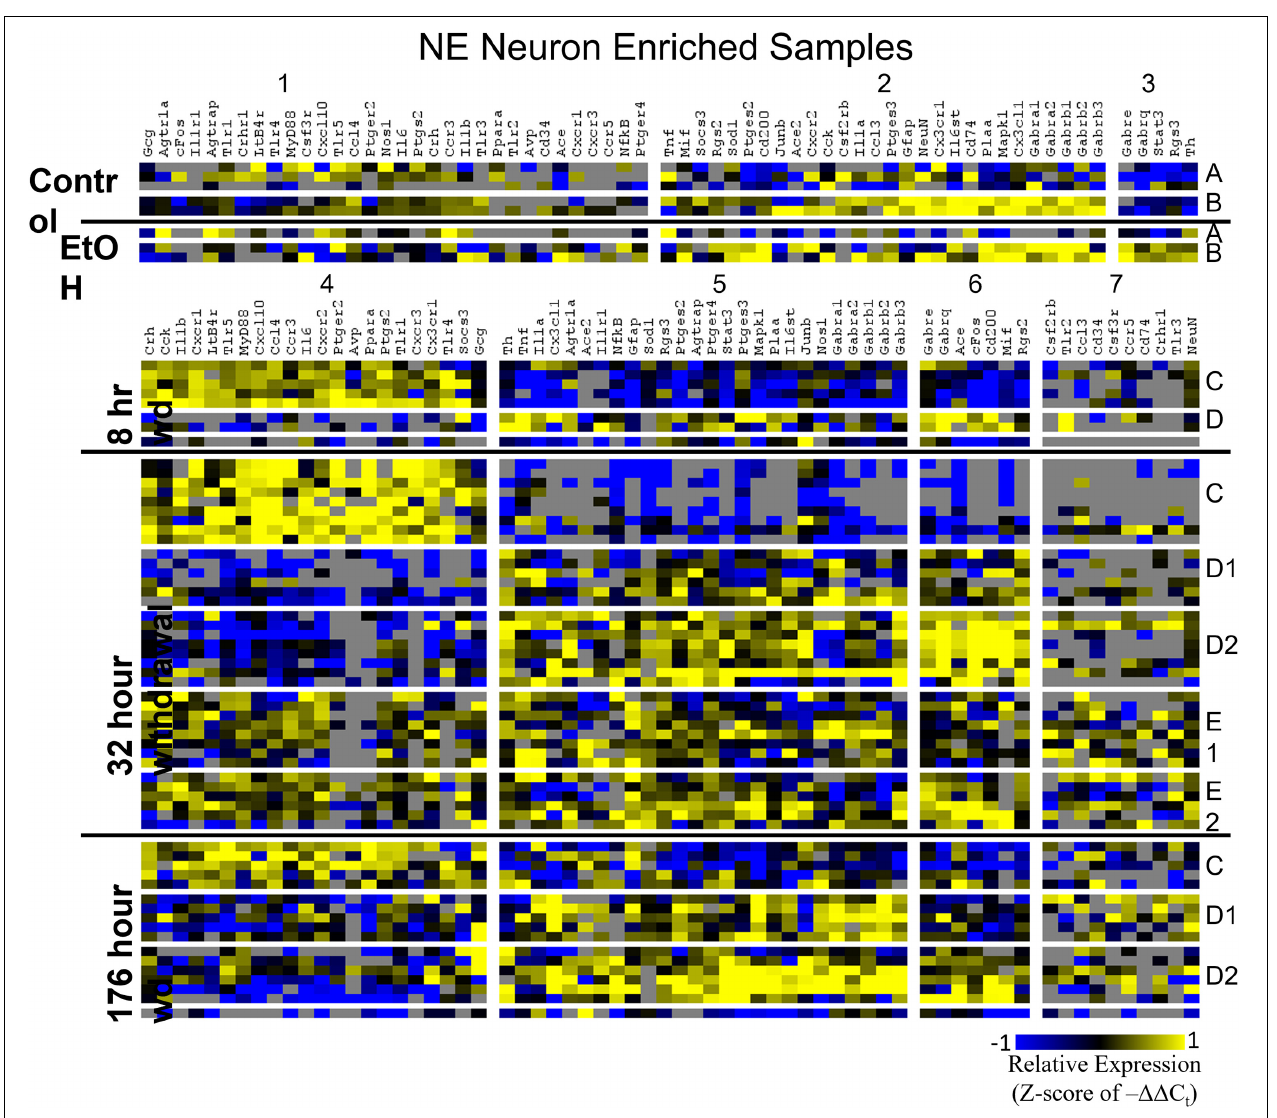
FIGURE 3 | Heat Map of NE Neurons. Heat map displays cellular subphenotypes within NE neurons enriched samples through alcohol withdrawal time series. Rows represent 10-cell pooled samples with cellular subphenotype clusters labeled with uppercase letters. Columns represent the z-score of – (cid:49)(cid:49) C t gene expression values on a –1 to 1 color scale for that gene in that sample. Gene clusters are labeled by